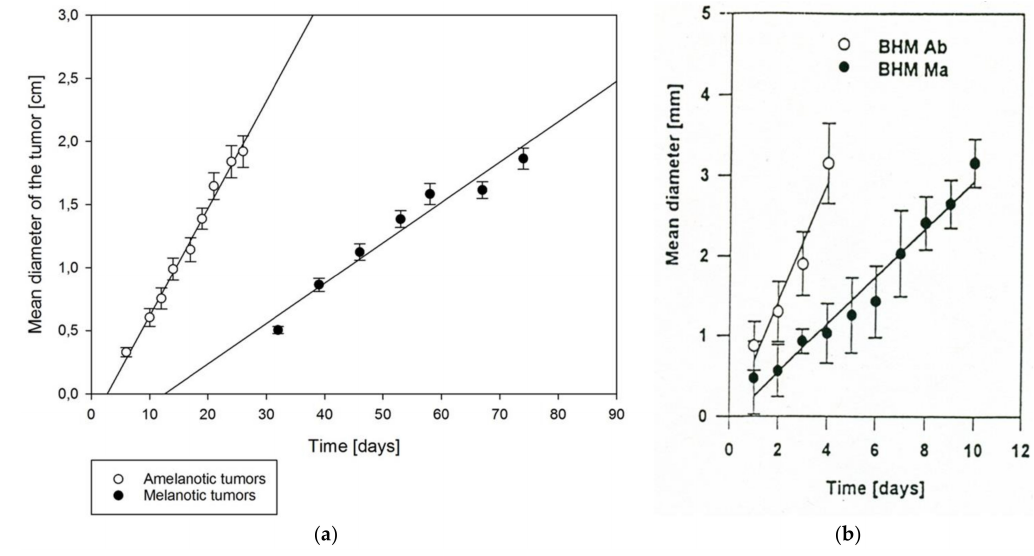
Figure 2. ( a ) The kinetics of Bomirski hamster melanoma (BHM) Ab and Ma tumors growth after subcutaneous implantation in Syrian Hamsters. White dots indicate amelanotic tumors growth in time, whereas black dots indicate melanotic tumors growth in time. Amelanotic tumors begin to grow 3 days after implantation, whereas melanotic tumors start growing 12 days after implantation. ( b ) The growth kinetics of BHM Ab [ ] ( n = 9) and BHM Ma [ ] ( n = 14) in the hamster eye. Each point represents the (cid:35) mean ± SEM